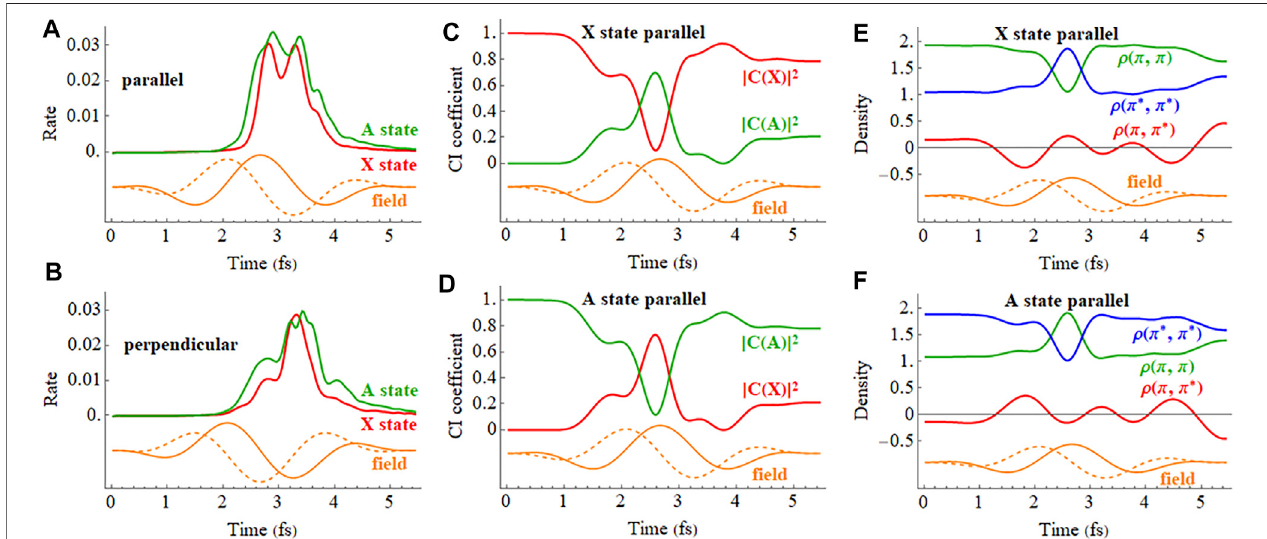
FIGURE 12 | (A,B) Ionization rate for the X and A cations in a 2 cycle circularly polarized 800 nm pulse with E max = 0.0566 au with the carrier envelope maximum parallel and perpendicular to the molecular axis (X in red, A in green). (C,D) CI coef fi cients for the X and A con fi gurations (red and green, resp.) in the normalized wavefunctionsfortheX( (cid:2) π p − 1 x )andA( (cid:2) π − 1 x )stateswiththecarrierenvelopemaximumparallelandperpendiculartothemolecularaxis. (E,F) Densitymatrixelementsforthe π π p x and x orbitals in the X and A states with the carrier envelope maximum parallel to the molecular axis (the orange traces are proportional to the electric movie of the hole density is available in Supplementary Figure S5 of the Supporting Information.